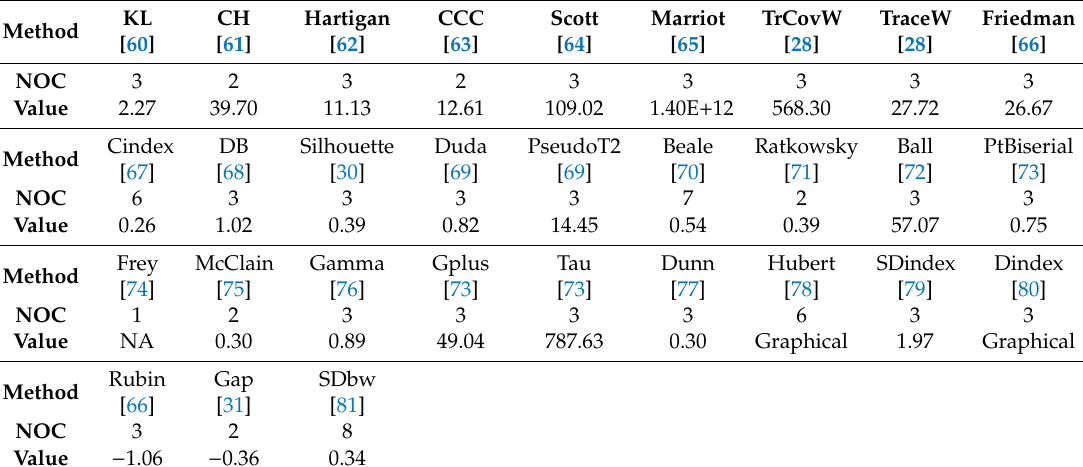
Table 3. Clustering validity indices results. NOC is an abbreviation for Number of